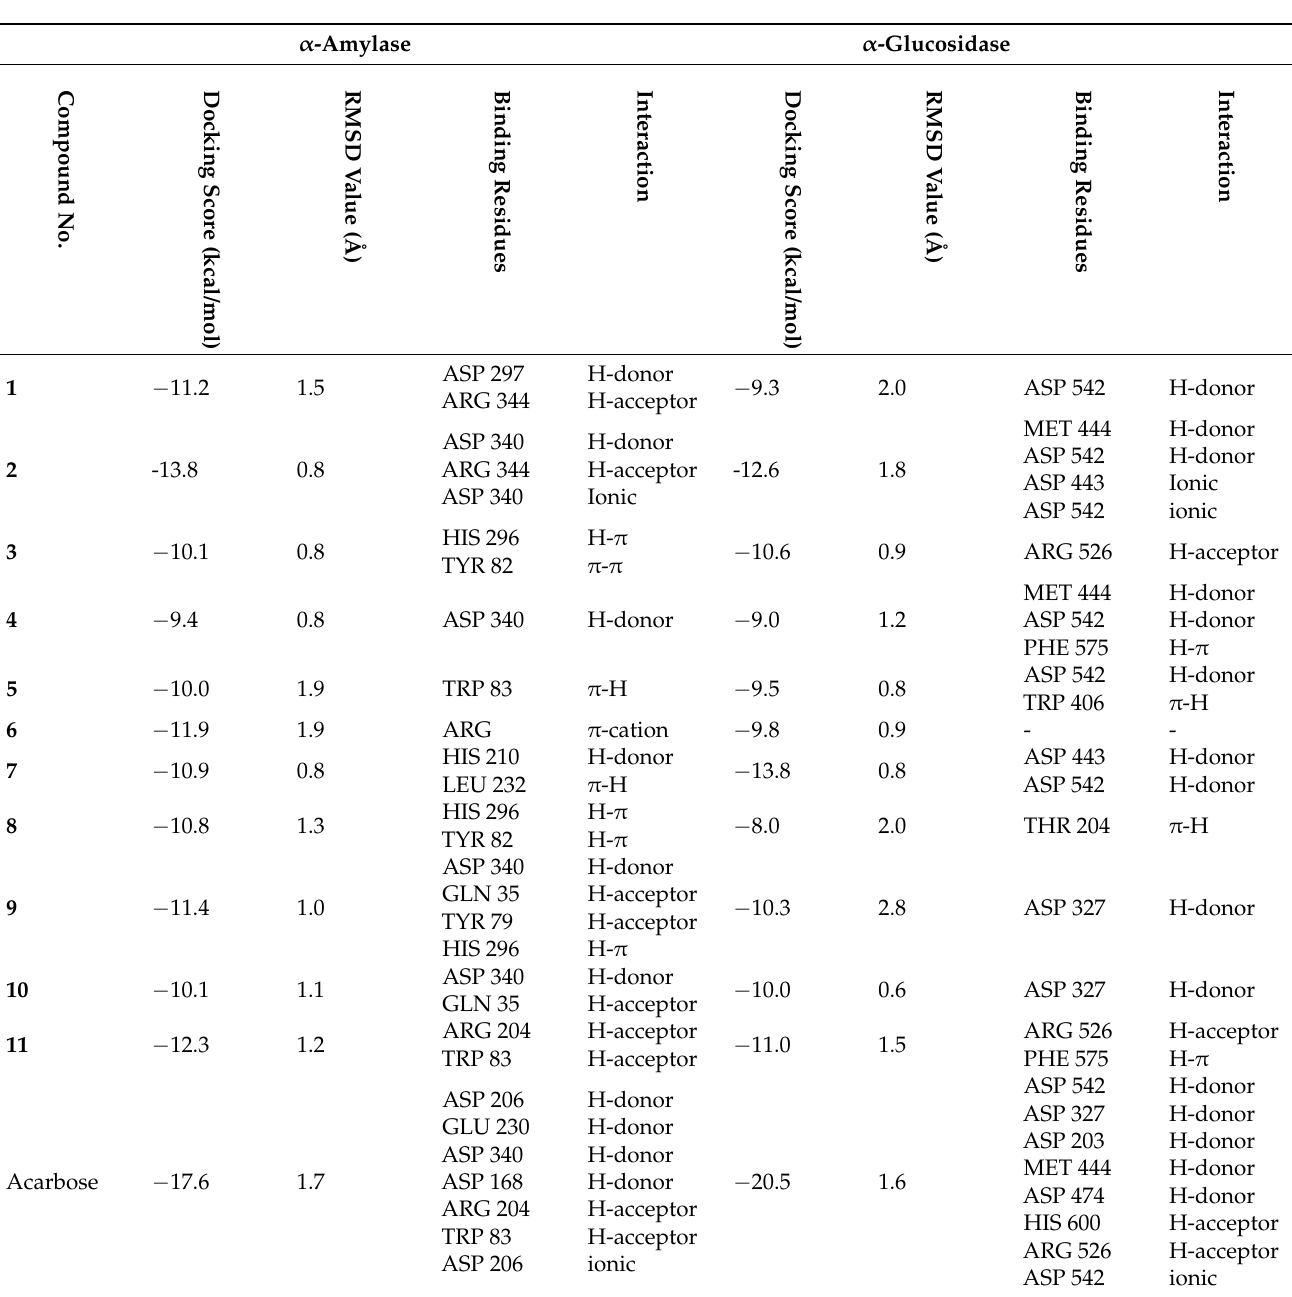
Table 4. The interactions and binding affinities of compounds 1 – 11 and acarbose with α -amylase enzyme (7TAA) and α -glucosidase enzyme (2QMJ) residues discovered during complex structure visualization. α -Amylase α